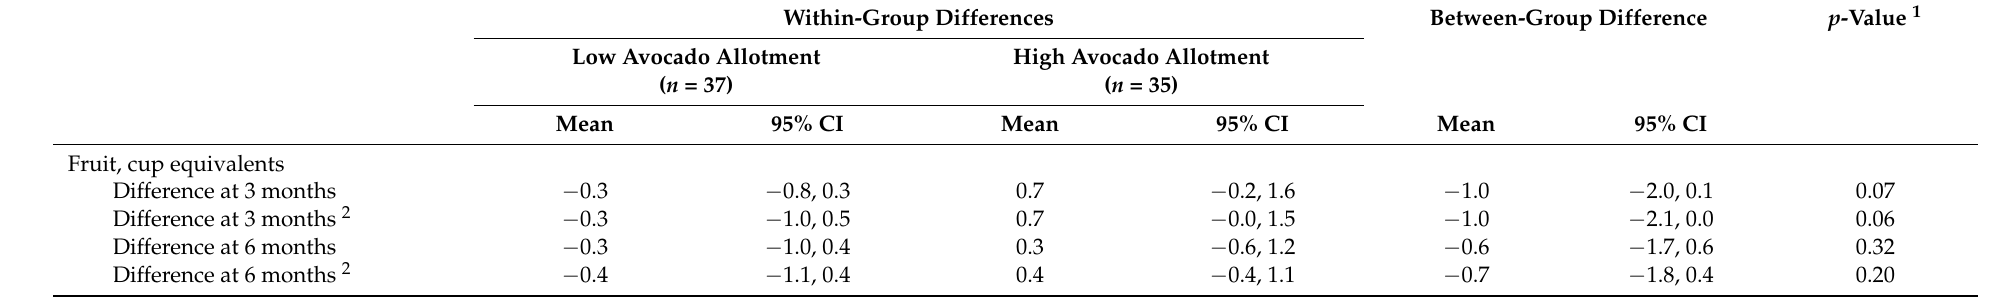
Table 4. Changes in family food group composition per intention-to-treat analysis in the Effects of Avocado Intake on the Nutritional Status of Families Trial ( n =